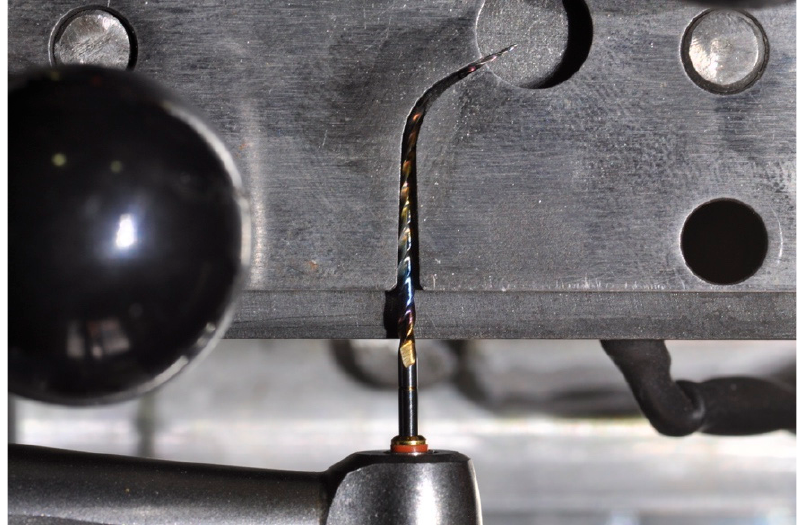
Figure 3. Part of instrument using TS2 CM-wire 1.2 that fractured during the cyclic fatigue test at body temperature. body